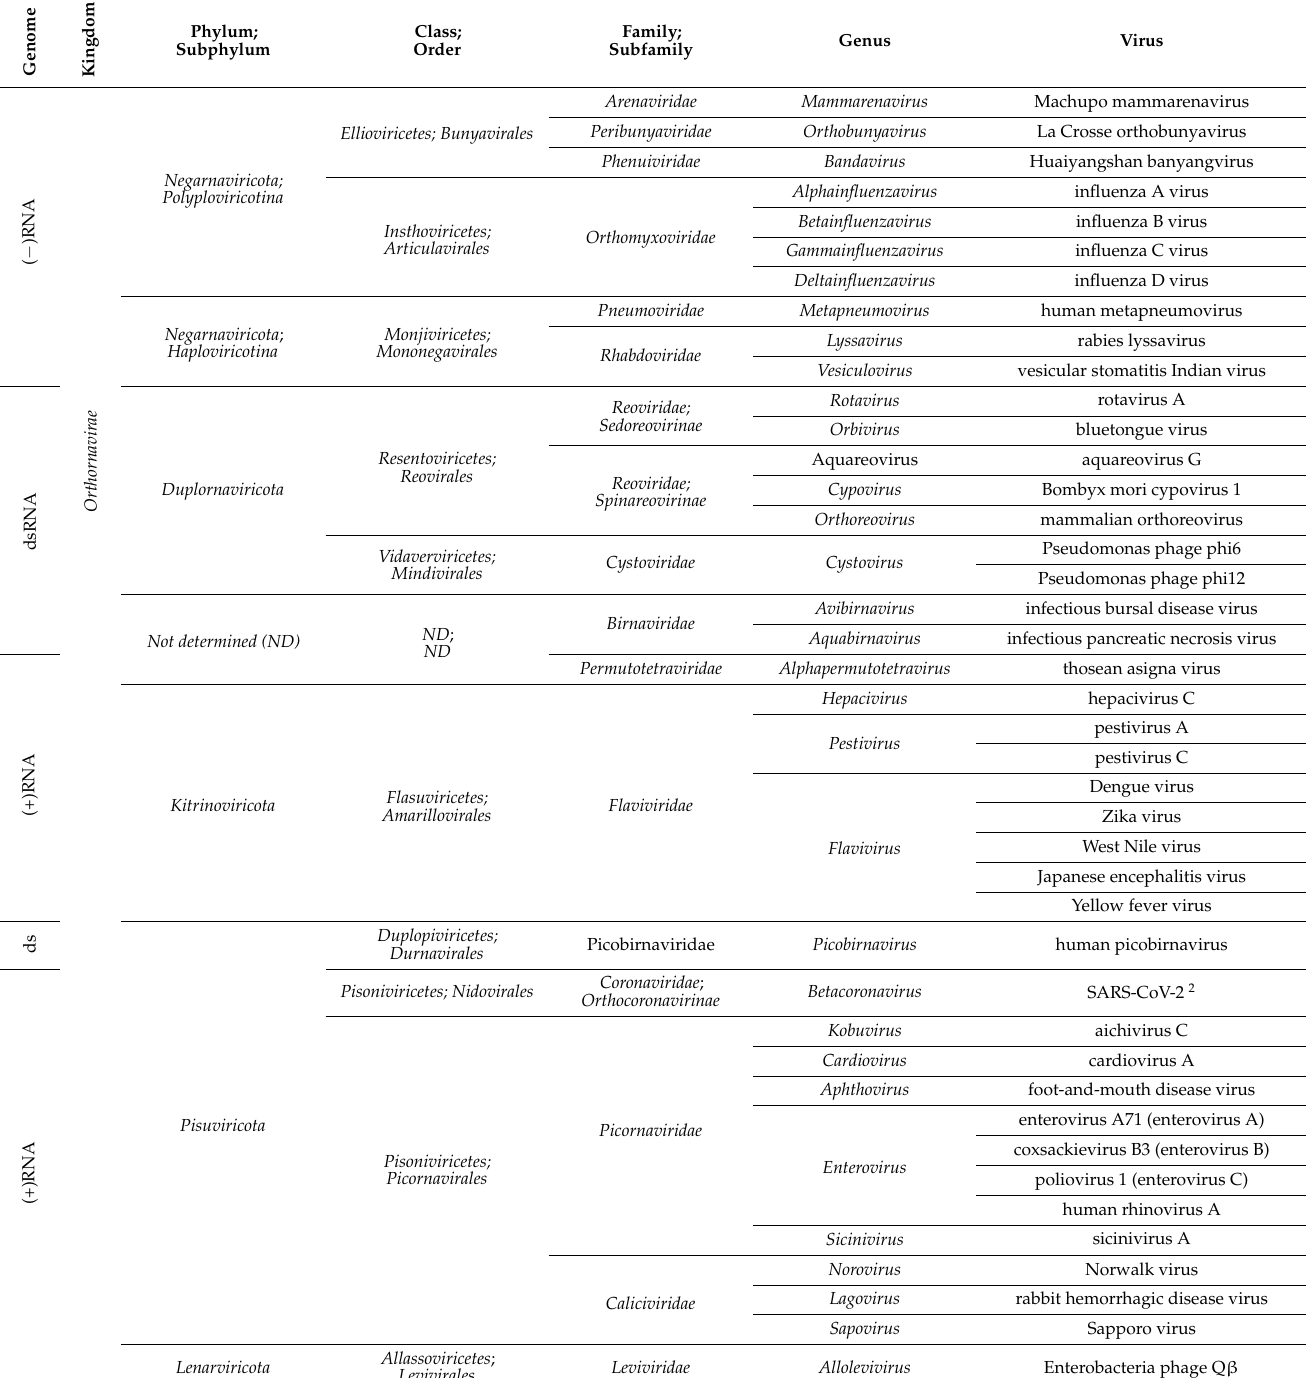
Table 1. Viral origin of RNA-dependent RNA polymerase structures used in this study and the taxonomy and genome type of the viruses 1